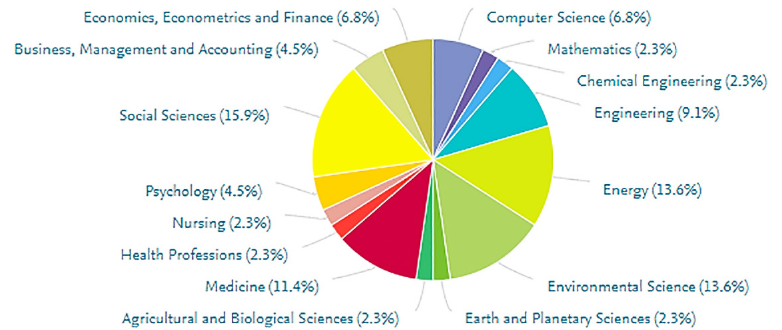
Figure A5. Structural analysis by subjects for the case of SDG 7 and